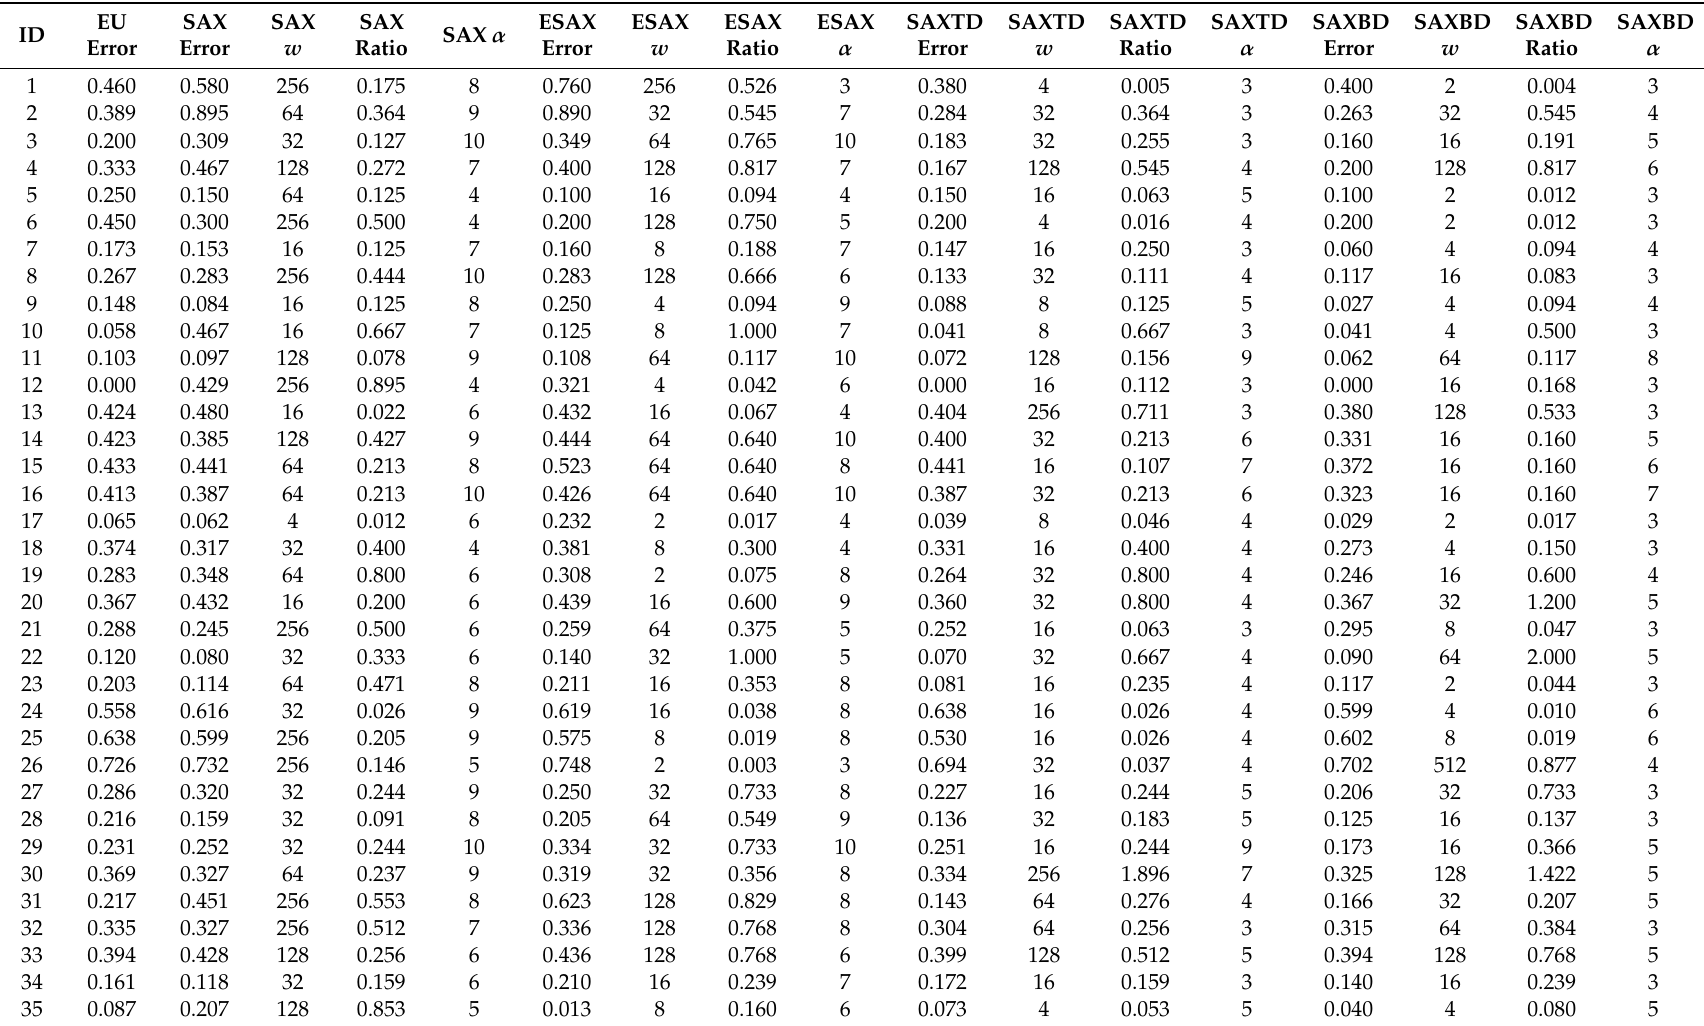
Table 3. 1-NN classification error rates of di ff erent